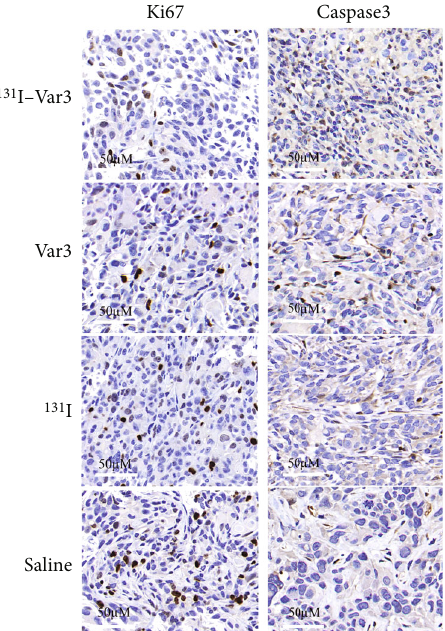
Figure 6: The immunohistochemical expression of Ki67 and caspase 3. The Ki67 expression was lower, and the caspase 3 expression was higher in the 131 I-Var3-pHLIP-treated group than in the other three groups (magni fi cation, ×